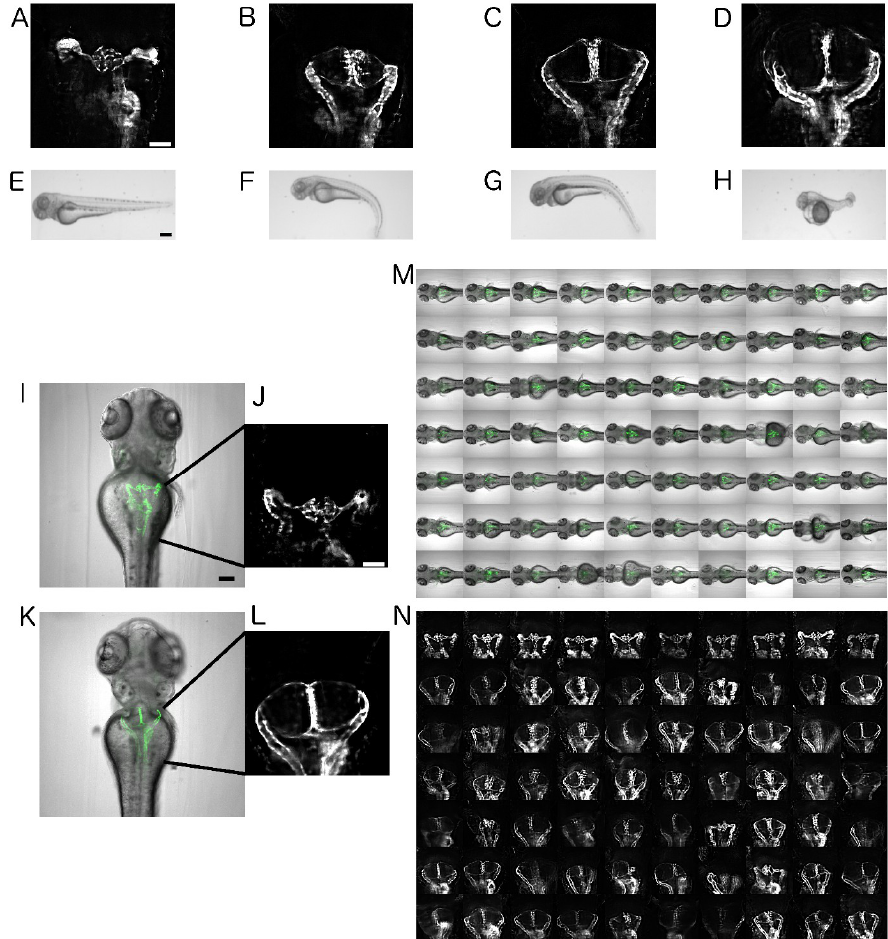
Figure 1. Automated imaging of an ift172-MO-based zebrafish model for human cystic kidney disease. ( A – D ) Dorsal views on pronephric areas in the Tg(wt1b:EGFP) embryos. Scale bar is 50 µ m. ( E – H ) Bright-field stereo microscope images of the dose–response curve of ift172-MO on 72 hpf zebrafish larvae. Scale bar is 250 µ m. ( A , E ) wild-type, ( B , F ) 50 µ M ift172-MO, ( C , G ) 100 µ M ift172-MO, and ( D , H ) 500 µ M ift172-MO. ( I , K ) Overlay images of bright-field and fluorescence channels